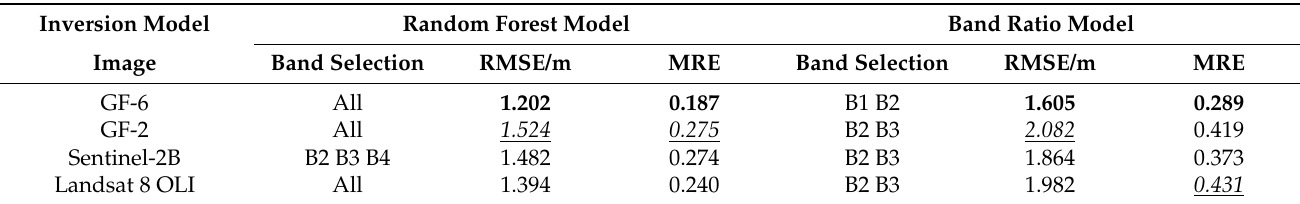
Table 2. Bathymetric inversion results from different multispectral images.